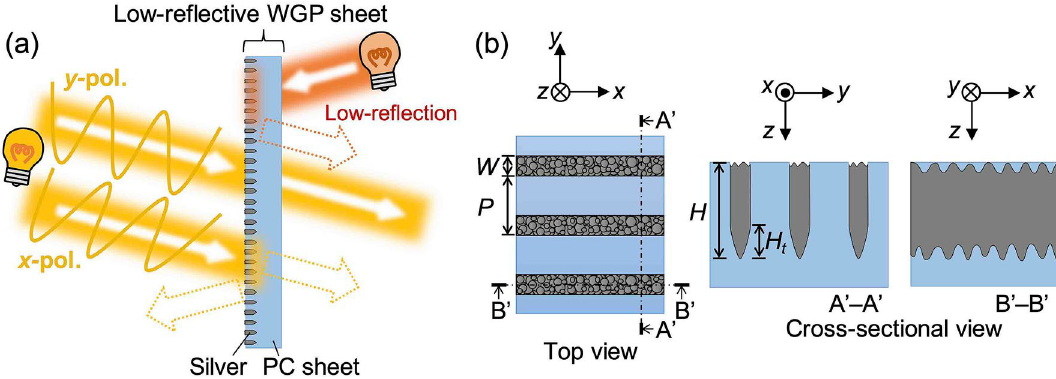
Figure 1. ( a ) Schematic of the low-reflective WGP sheet. ( b ) Schematics of the top and cross-sectional views of the surface